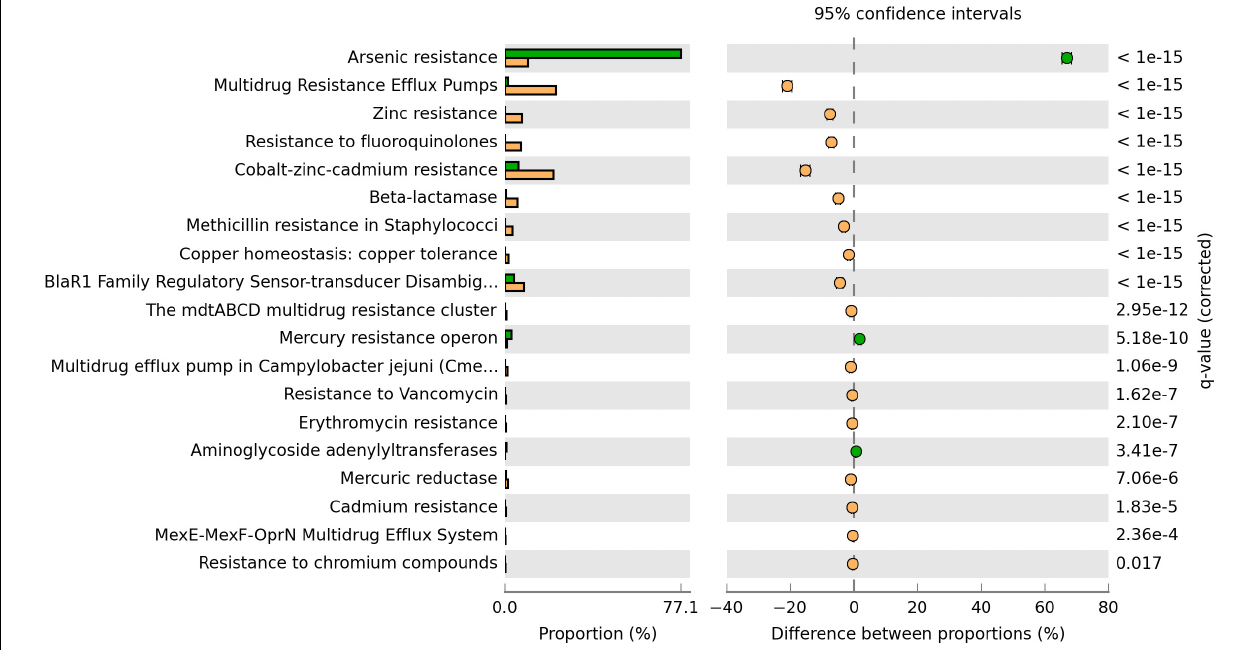
FIGURE 3 | Comparison of the functional profile derived from the Puquio de Campo Naranja plasmidome (orange bars) with the one derived from the wastewater treatment plant plasmidome in Visp, Switzerland (green bars). Percent “Resistance to antibiotics and toxic compounds” categorizable protein coding genes belonging to the “Virulence, Disease and Defense” SEED subsystem, and pairwise proportional differences calculated using STAMP (Statistical Analysis of Metagenomic Profiles). Fisher’s exact test was used and corrected P -values were calculated using Benjamini-Hochberg‘s FDR. Only the statistically significant SEED subsystems are shown ( q <